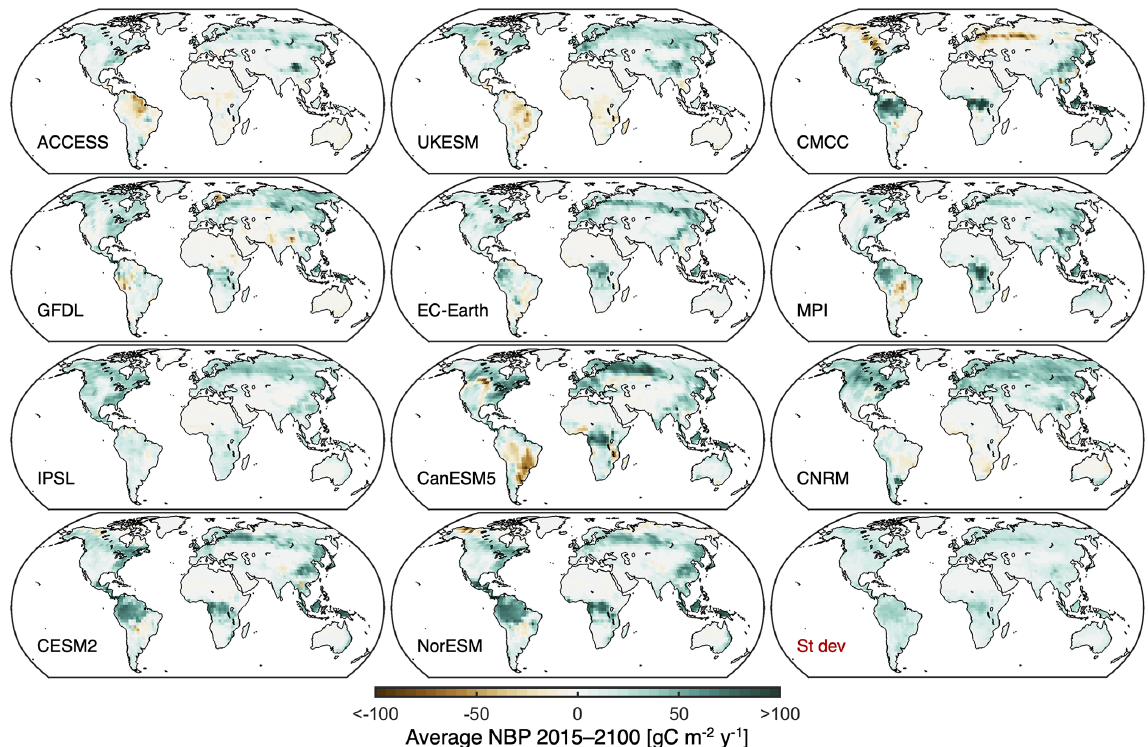
Figure 2. Intermodel differences in regional projected NBP. Maps of average projected NBP during 2015 to 2100 from individual models. The intermodel standard deviation is shown at the bottom